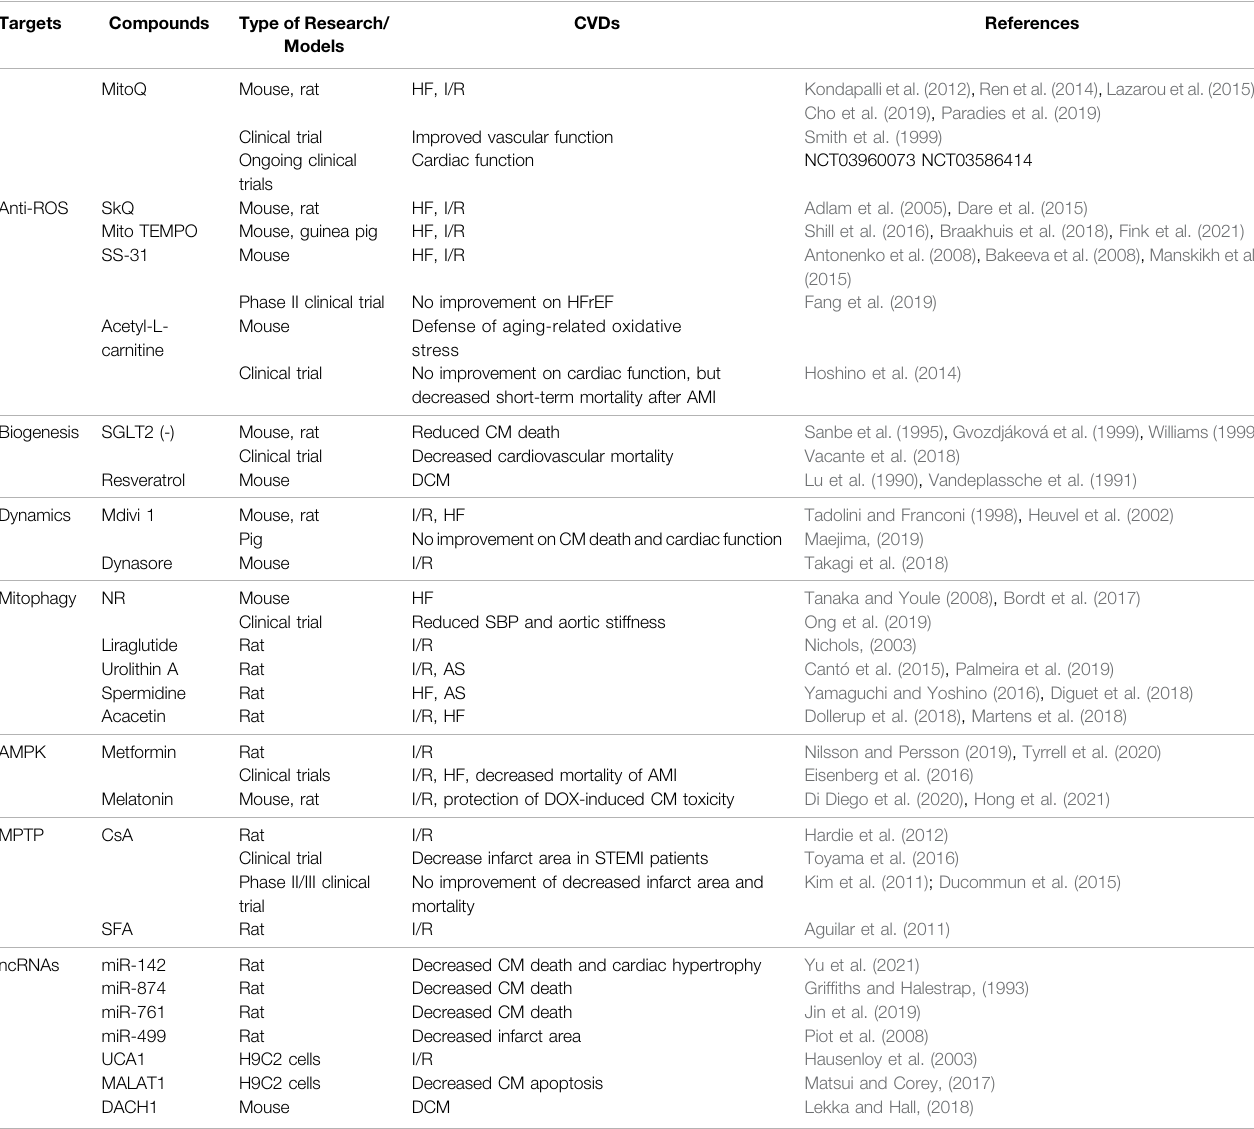
TABLE 1 | Summary of pre-/clinical evidence of potential mito-targets in CVDs Targets